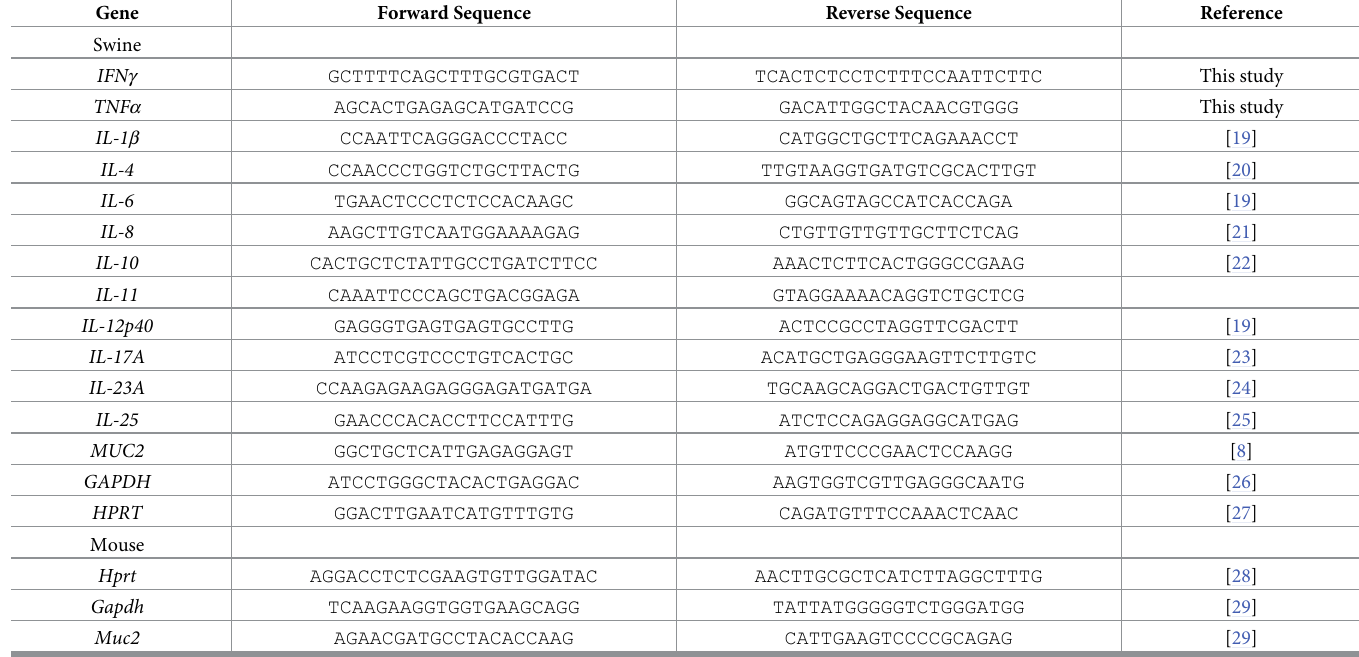
Table 2. Sequences of primers used in this study for cytokine profiling.